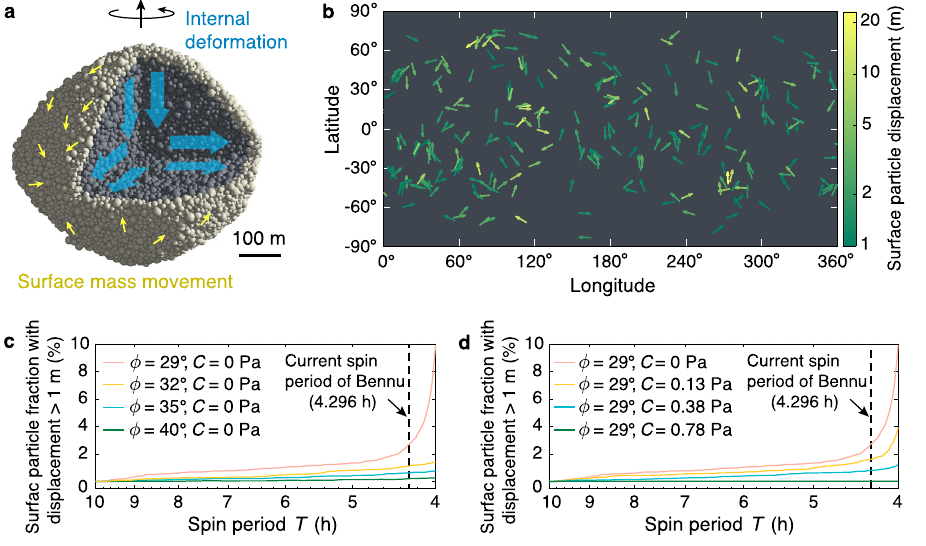
Fig. 1 | Surface mass movement on the Bennu-shapedrubble pileduring YORP spinup. a Cut-away schematic of the Bennu-shaped rubble-pile model, where surface particles are highlighted in beige (i.e., the top 25-m-depth layer, where the total particle number is 11,148). The blue and yellow arrows indicate the general internaldeformationandsurfacemassmovementdirection.Therotationdirection isindicatedbytheblackarrowsonthetop. b Surfaceparticlemovementmapinthe